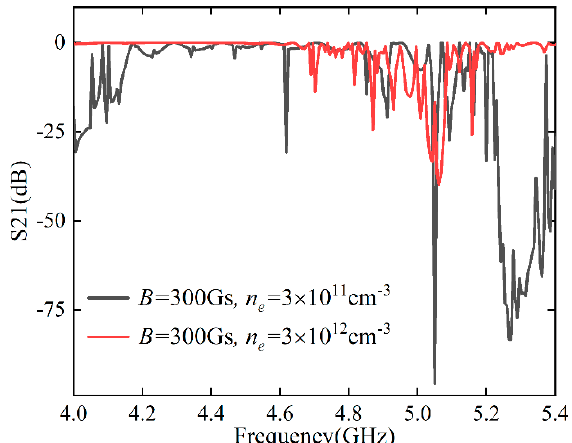
Figure 4. The transmission spectra of the PPC at different magnetic fields considering TE polariza- tion.